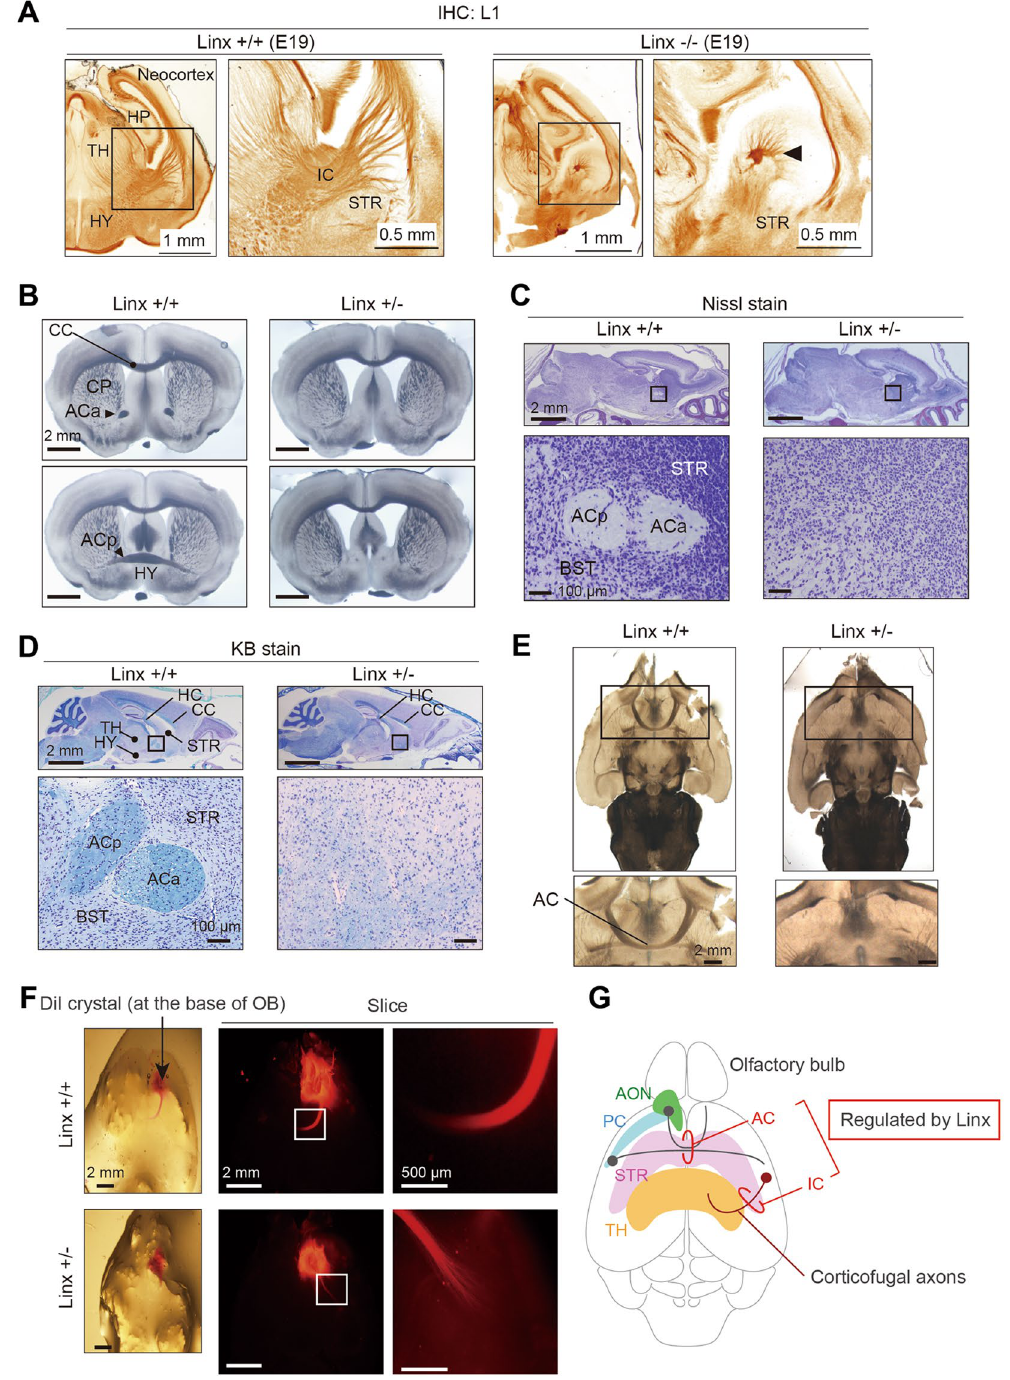
Figure 3. Defective AC development in Linx + / − mice. (A) A defect in IC development found in Linx − / − mice. The coronal sections of brains from Linx + / + (left) and Linx − / − (right) E19 embryonic mice were stained for L1, a neuronal adhesion molecule, to visualize the IC. An arrowhead denotes the remnants of the descending component of the IC. Boxed areas were magnified in the adjacent panels. (B–D) Transmitted light (B) , Nissl-stained (C) , and KB-stained (D) images of coronal sections from P30 mouse brains showing the defects in the AC of Linx + / − mice. ACp, posterior branch of the AC; ACa, anterior branch of the AC; TH, thalamus; HC, hippocampal commissure; BST, bed nuclei of the stria terminalis. (E) Horizontal sections from the brains of wild-type (left) and Linx + / − (right) mice showing defective AC development in Linx + / − mice. Boxed areas are magnified in the lower panels. (F) The axon tract from the AON was labeled with DiI crystals placed around the AON regions prepared from wild-type and Linx + / − mice. The axon tract that constitutes the anterior branch of the AC was short and disrupted in Linx + / − mice compared with wild-type mice. Boxed areas are magnified in the adjacent panels. (G) A schematic illustration representing the neural projections regulated by Linx; this is based on data from both previous 12 and present